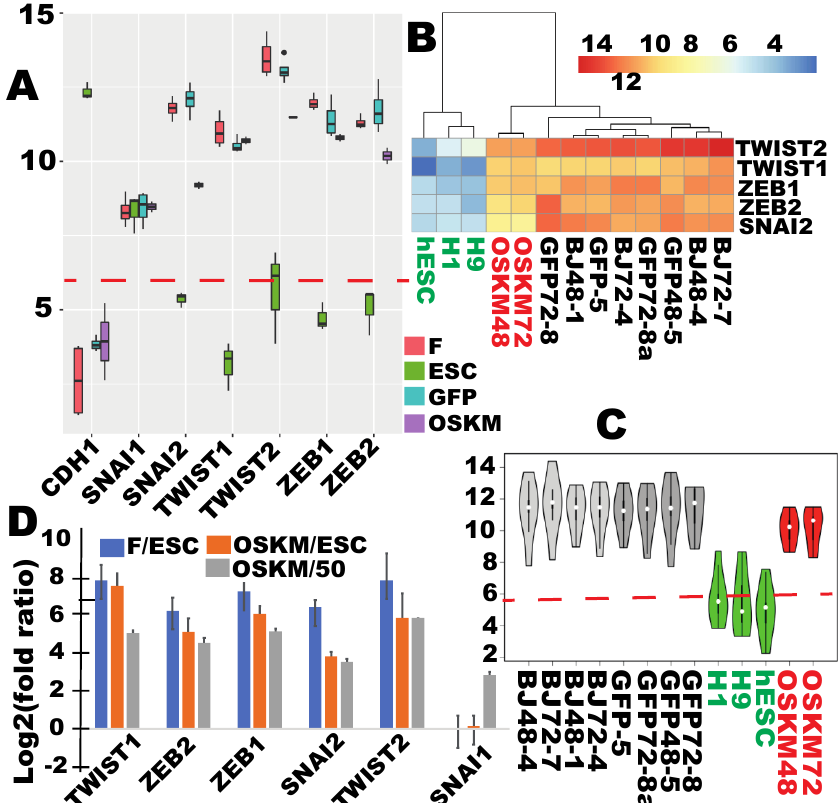
Figure 3. The key mesenchymal transcriptional factors (TFs) maintained high levels of expressions and the epithelial marker CDH1 remained silenced at the time of proper RB reprogramming. ( A ) Box plots for individual genes showing little reprogramming of mesenchymal TFs, and of the epithelial marker gene CDH1 at the early time of OSKM reprogramming (log2-transformed averaged read counts for time points of 48 and 72 h). ( B ) Clustering and the associated heat map showing lack of substantial downreprogramming of the five mesenchymal TFs. ( C ) Violin plots of each sample for the six mesenchymal TFs showing little reprogramming as a group upon OSKM induction. ( D ) Log2 (fold differences) relative to ESCs (blue and orange bars) or to the threshold level read counts (50) for the expressed genes (grey bars). F in (A) and (D) stands for fibroblasts. Dashed red lines in (A) and (C) mark the threshold level of the expressed genes. Sample labels are the same as in Figure 2. See also Supplementary Figure S7 and Supplementary Table S11.